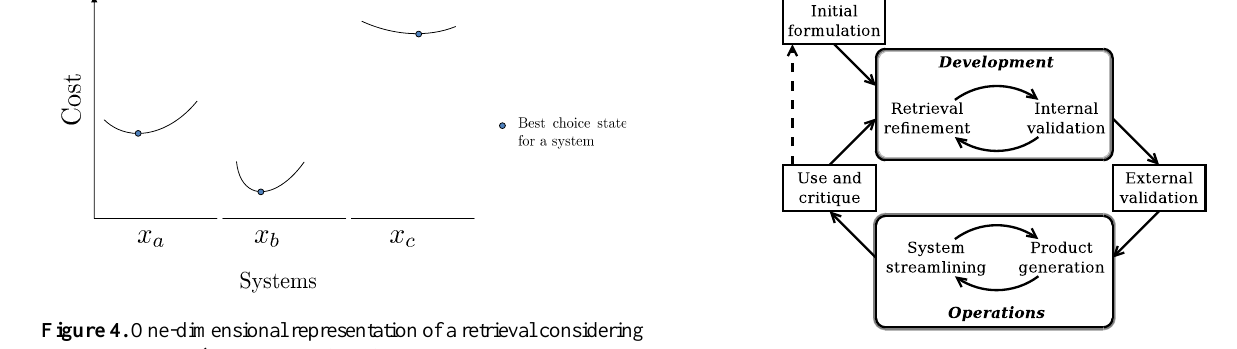
Figure 5. The cycle of retrieval development. The initial formula- tion and algorithm are repeatedly revised in light of internal valida- tion activities. When consistent results are achieved, an external val- idation is performed (and published) to begin the operational cycle, where data are generated and disseminated. The application and cri- tique of the data by the scientific community then feeds into further refinement of the algorithm (or entirely new algorithms). The devel- opment and operational cycles continue independent of the larger cycle but over time operations will increasingly dominate resources as the product becomes increasingly fit for